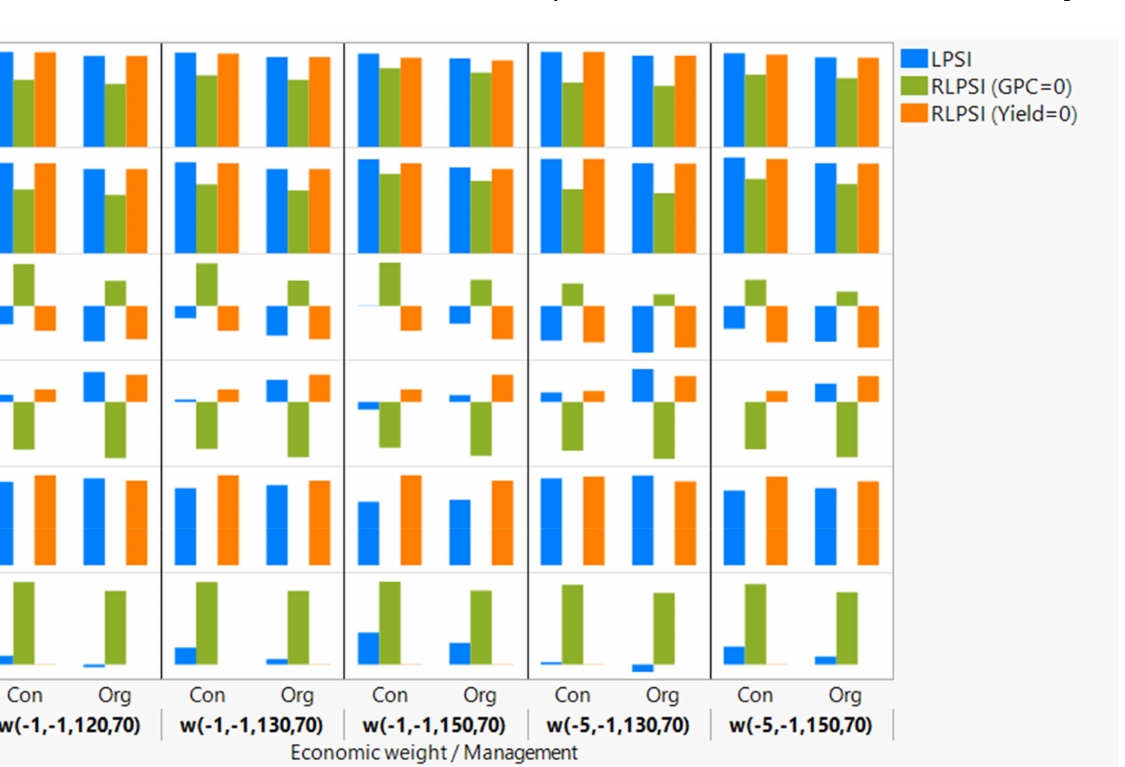
Figure 3. Bar graph of expected genetic gain (EGG) for grain yield (Yield), plant height (Pht), maturity (Mat), and grain protein content (GPC) plus response to selection and the correlations between each index and the genetic merit based on the Smith Linear Phenotypic Selection Index (LPSI) and Kempthorne and Nordskog Restrictive Linear Phenotypic Selection Index (RLPSI). The RLPSI analyses were done by restricting the expected genetic gain either for yield or GPC to zero. The best linear unbiased estimators computed from the conventionally or organically managed environments and five economic weights (w) were used in the analysis. The economic weights, such as w( − 1, − 1, 120, 70) refer to an economic weight of − 1 for maturity, − 1 for plant height, 120 for grain yield, and 70 for GPC, respectively. See Table S6 for